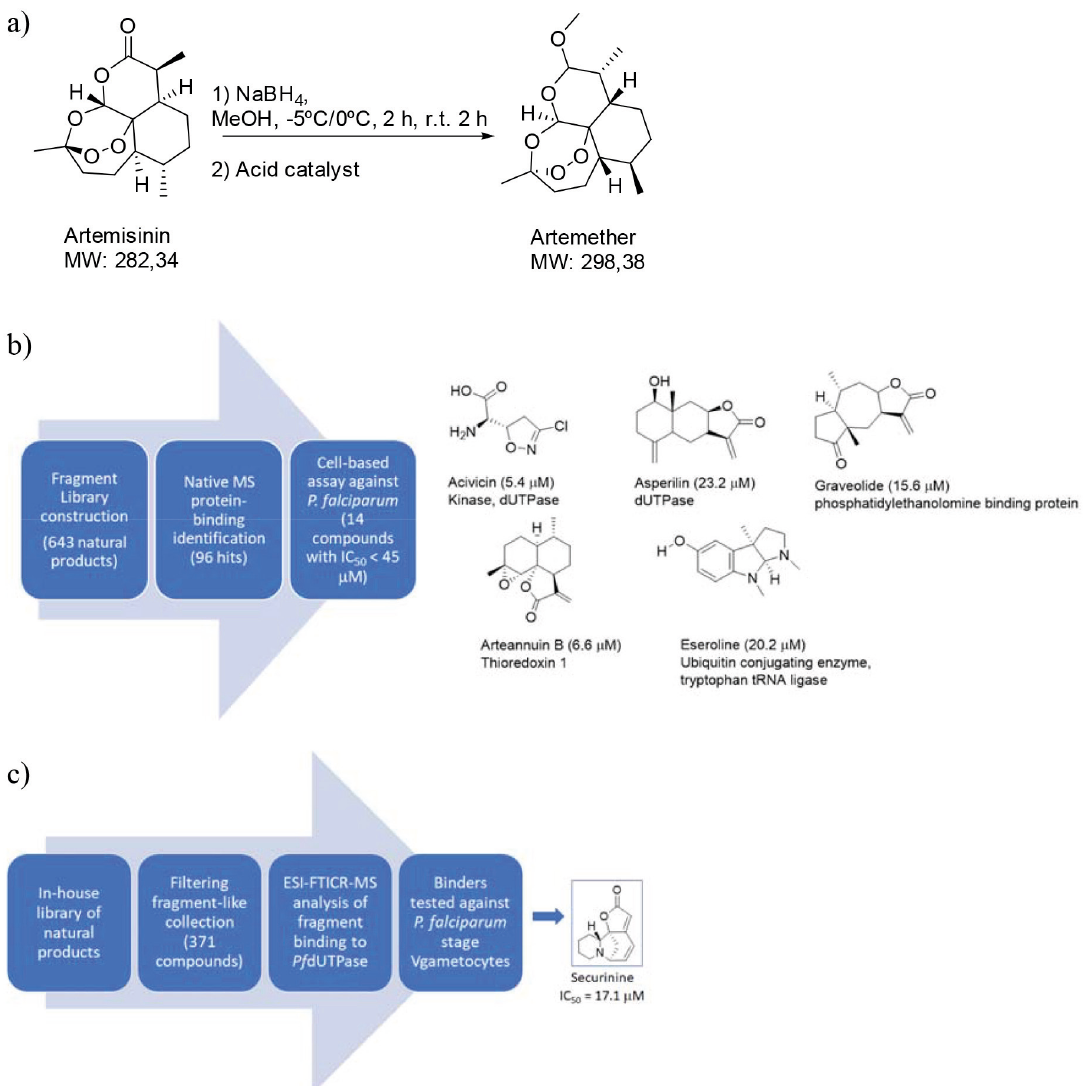
FIGURE 5 - Different approaches for developing bioactive compounds from fragment-sized natural